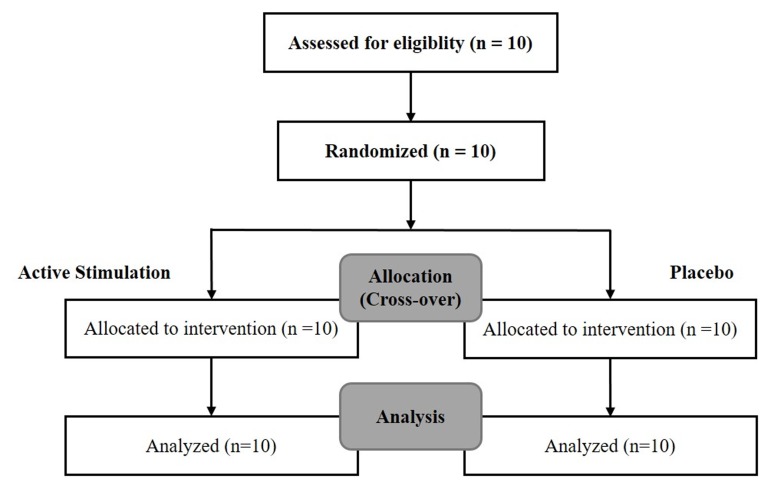
The consort flow chart of the first arm of the study.